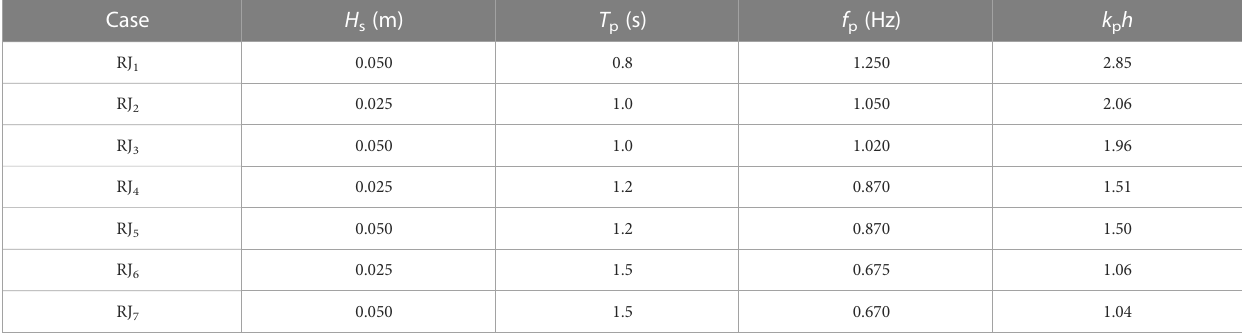
TABLE 1 Experimental parameters for the